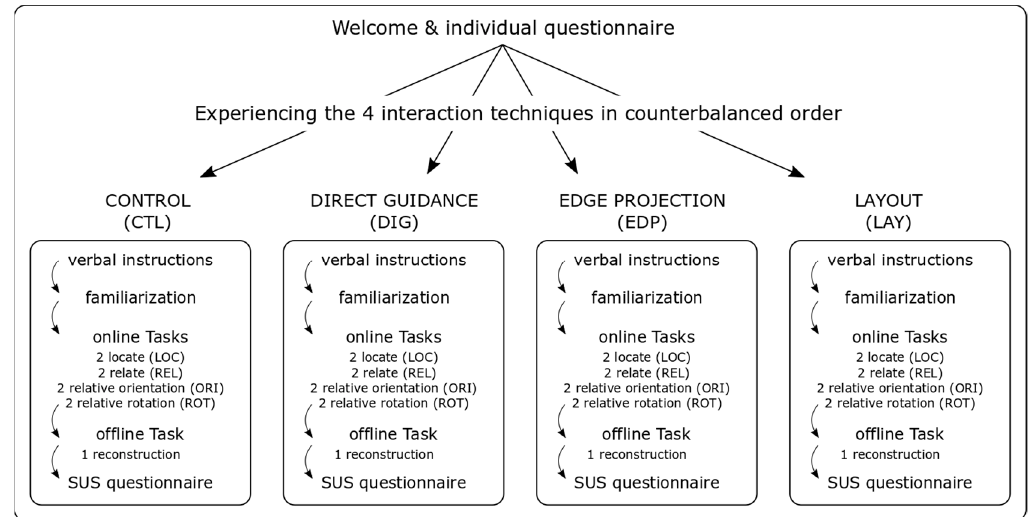
Figure 6. Experimental plan overview.